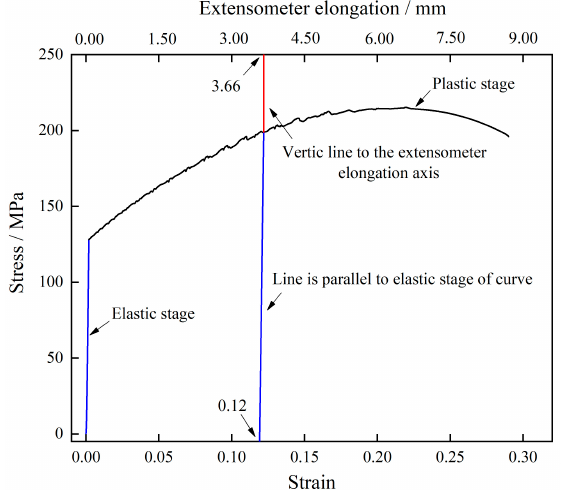
Figure 2. Tensile stress–strain curve of annealed alloy plate and schematic of pre-tensile deformation controlled by a large range extensometer.